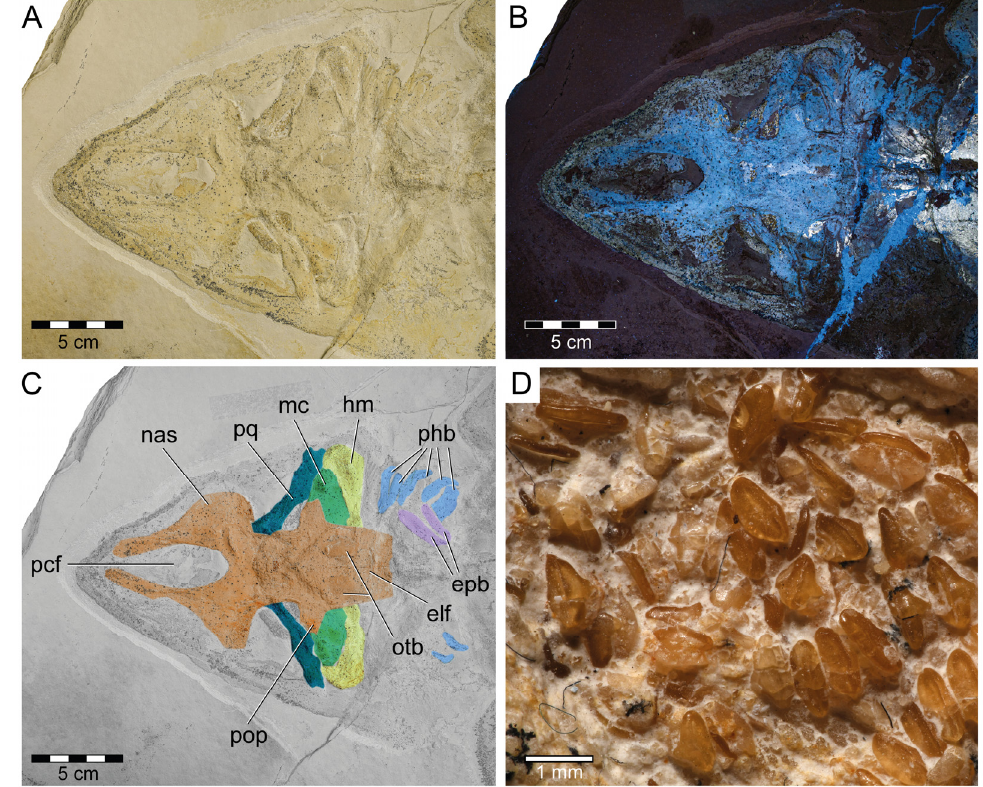
Figure 4. Head and teeth of Protospinax annectans Woodward, 1918, PBP-SOL-8007, from the lower Tithonian of the Solnhofen Archipelago, Bavaria, Germany. ( A ) Head region under normal light; ( B ) head region under UV light; ( C ) color-coded skull, showing the preserved skeletal elements of the neuro- and splanchnocranium; ( D ) close-up image of the teeth. Abbreviations : elf , endolymphatic fossa; epb , epibranchial; hm , hyomandibula; mc , Meckel’s cartilage; nas , nasal capsule; otb , otic bullae; pcf , precerebral fossa; phb , pharyngobranchial; pop , postorbital process; pq , palatoquadrate.